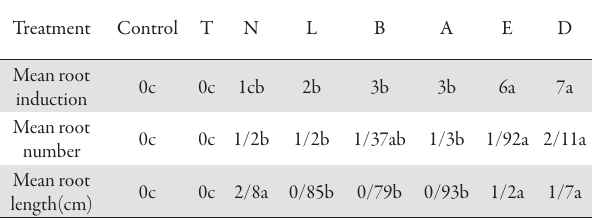
Tab. 6. Effect of different PGRs treatment on rooting stage